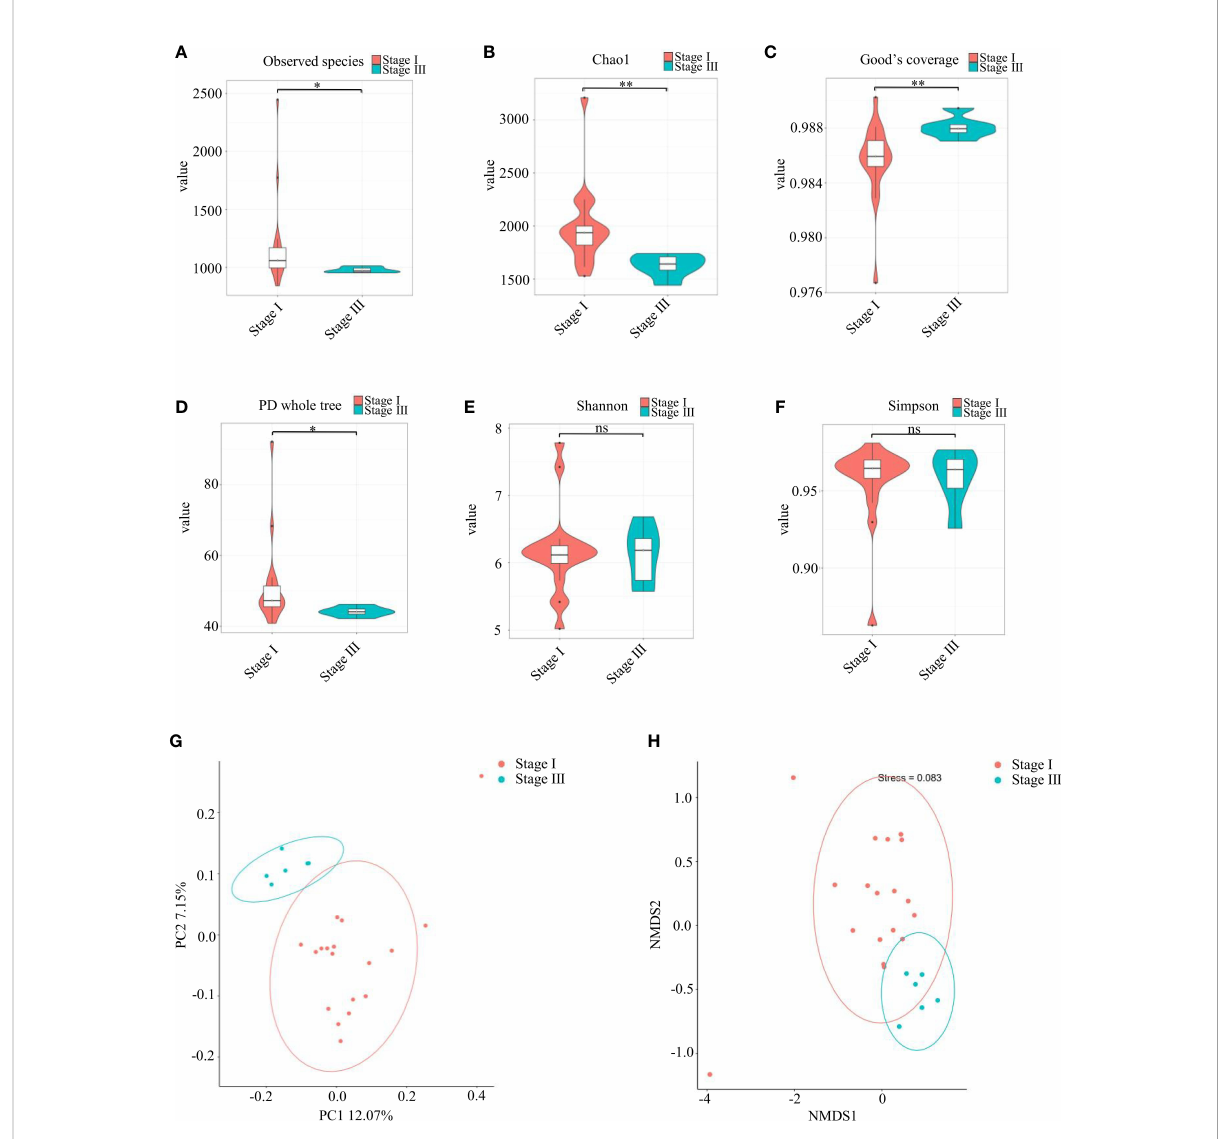
FIGURE 2 Analyses of a -diversity and b -diversity. (A – F) Violin plots of a -diversity indices (Observed species, Chao1, Good ’ s Coverage, PD Whole Tree, Simpson, Shannon) comparing stage I (red) and stage III (green) samples. ( ∗∗∗ P <0.001, ∗∗ P <0.01) ns, no signi fi cance. Based on the unweighted UniFrac distance, (G) principal coordinates analysis (PCoA) and (H) non-metric multidimensional scaling (NMDS) were used to analyze similarity in microbial